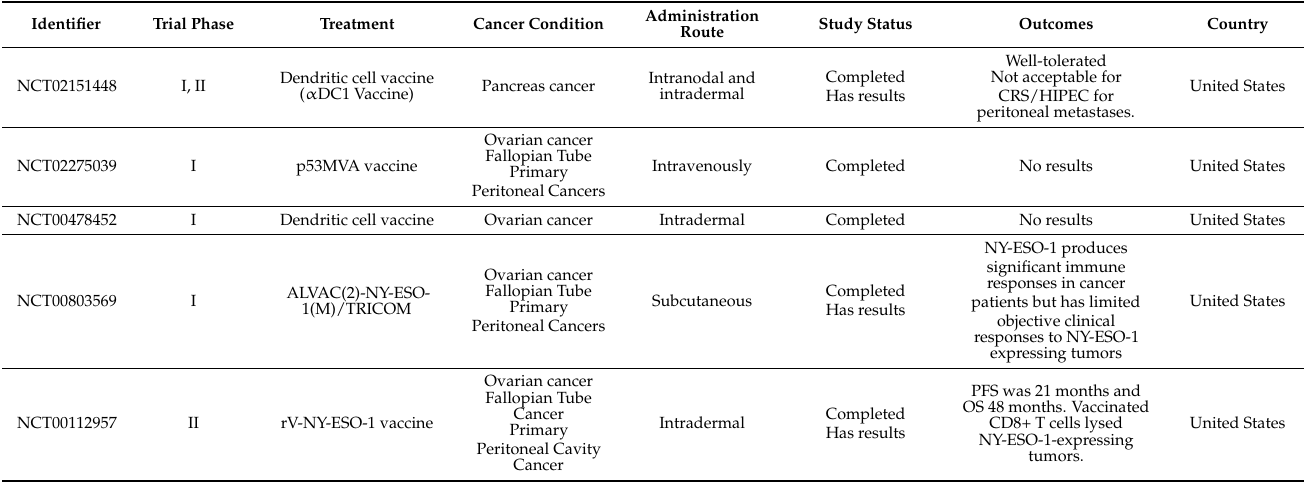
Table 3. Ongoing clinical trials with cancer vaccine therapy in PC (source: clinicaltrials.gov (accessed on 25 February